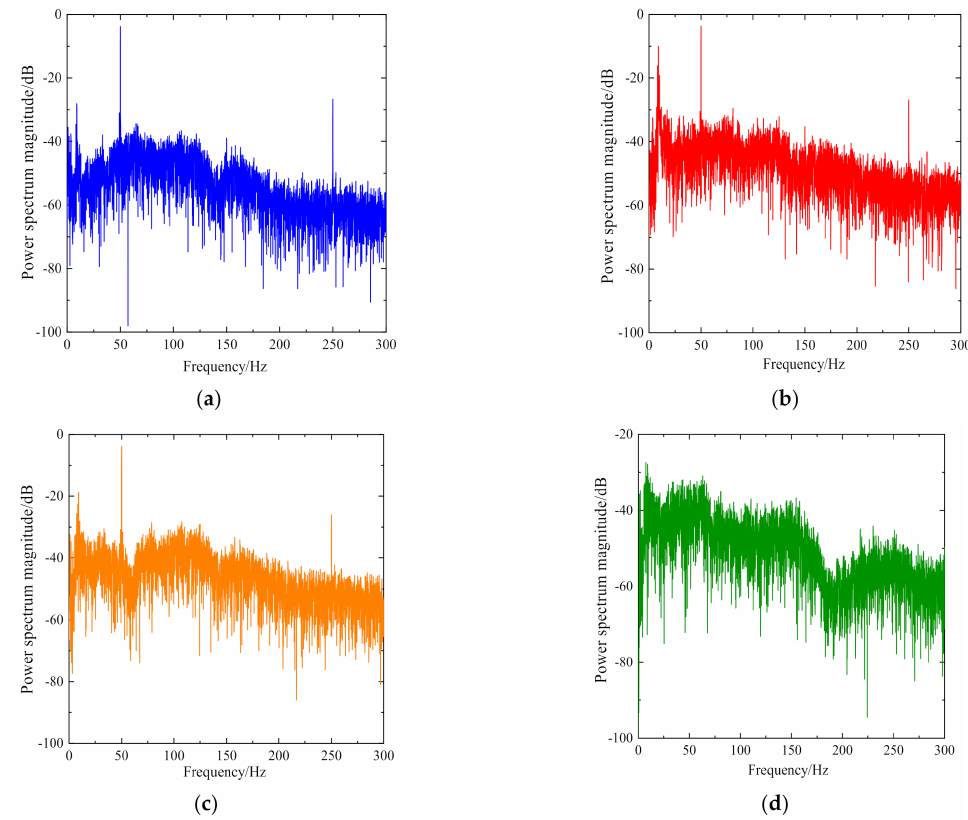
Figure 10. Power spectrum of the acceleration measured in the horizontal cutting experiment. ( a ) x -direction of the cutting head, ( b ) y -direction of the cutting head, ( c ) z -direction of the cutting head, ( d ) y -direction of the cutting